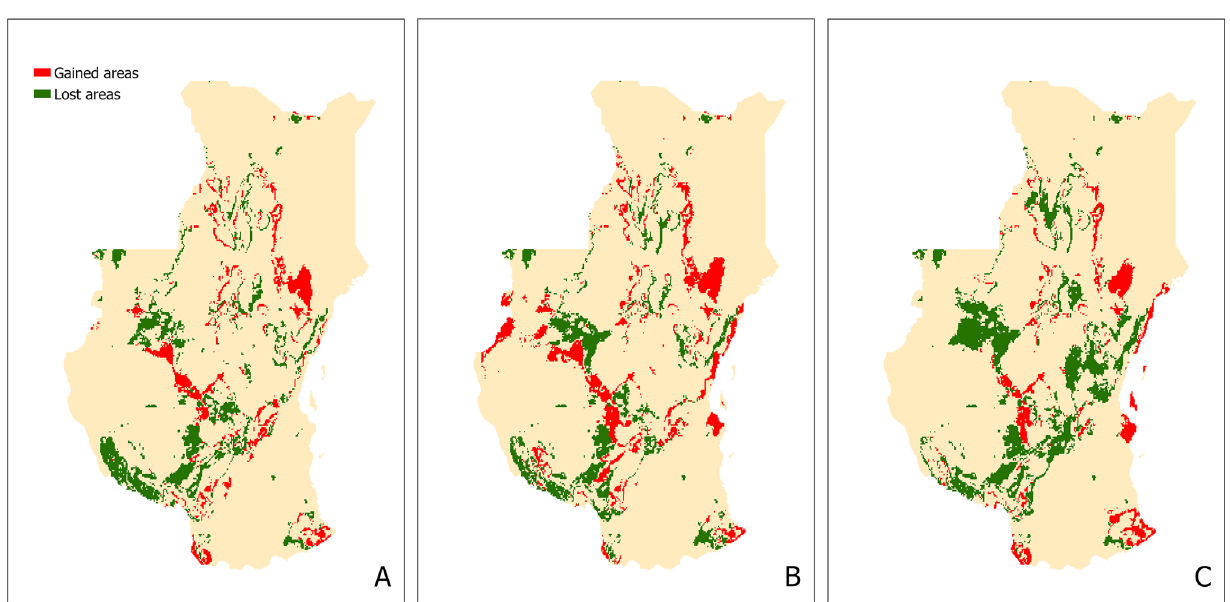
Figure 3. S. exempta future environmental suitability maps for Kenya and Tanzania for 3 different CO 2 emission scenarios. ( A ) 2061-2080 SSP1-2.6, ( B ) 2061-2080 SSP3-7.0, ( C ) 2061-2080 SSP5-8.5. Gained areas are areas where the present-time model predicts as non-suitable, and the future-time model as suitable; lost areas are areas where the present-time model predicts as suitable, and the future-time model as non-suitable. Maps were generated in R v.4.0.2 104 (https:// www.r- proje ct. org/) using RStudio v.1.3.1093 (https:// www. rstud io.